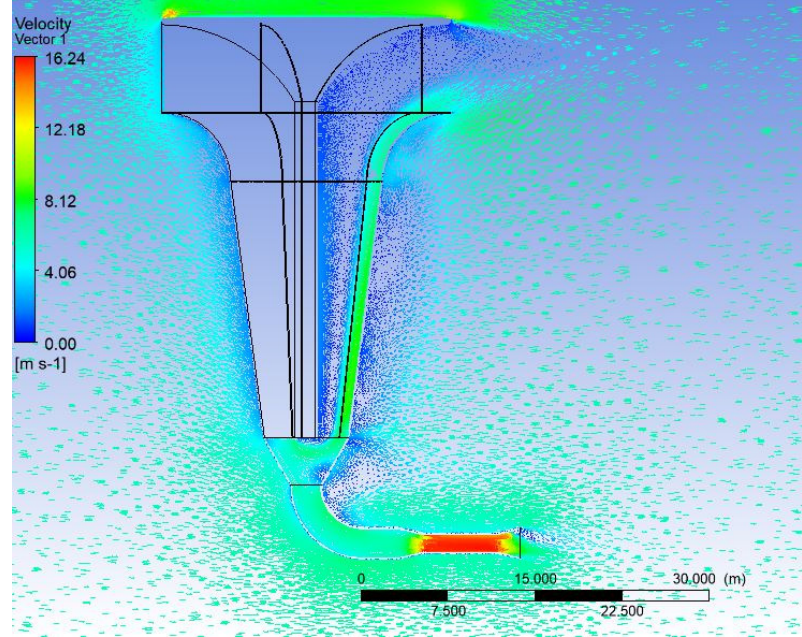
Figure 5. Velocity vector of the omni-directional wind funnel.